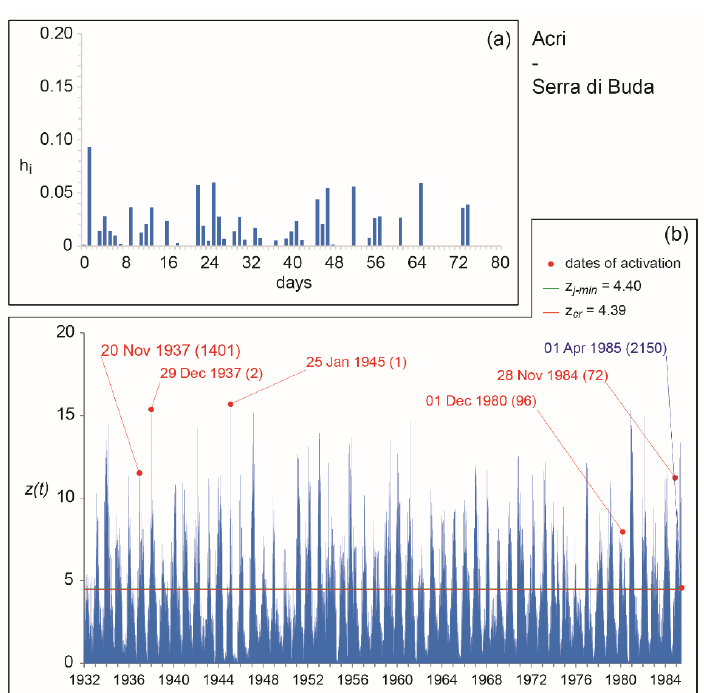
Figure 7. Acri—Serra di Buda case study: ( a ) optimal kernel; ( b ) mobility function obtained by applying the optimal kernel to the entire set of available activation dates (cf. [50]).